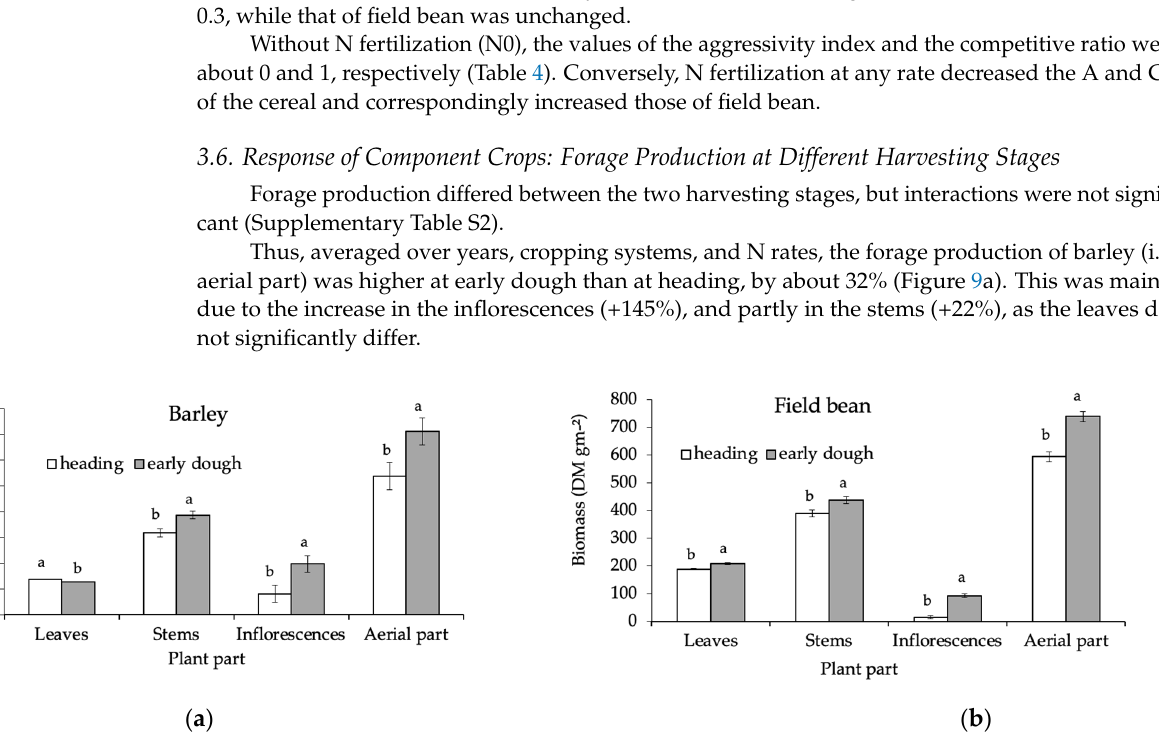
Figure 9. Harvesting stage main effect on forage composition of ( a ) barley and ( b ) field bean. Values are means of two years, five N rates, two cropping systems, and three replicates. Vertical lines represent HSD and values with the same letter are not statistically different for p ≤ 0.05.